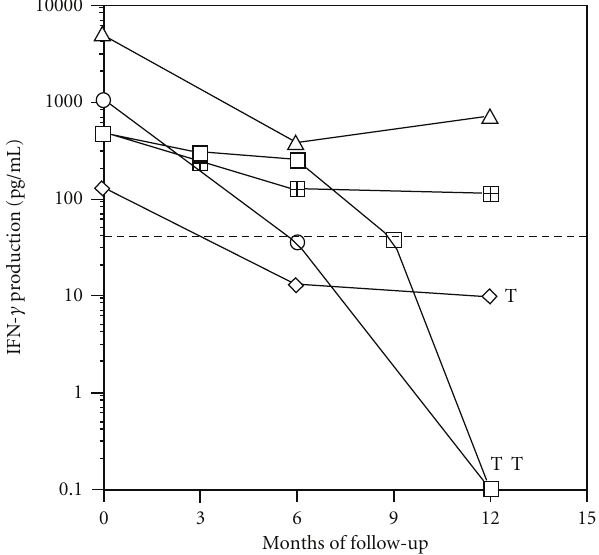
Figure 5: Evolution of Ag85-specific IFN- γ response in 5 HIV- positive latently infected subjects. Individual IFN- γ production (pg/mL) of PBMC in response to Ag85 from 5 tuberculin- positive/HIV-positive subjects at baseline t = 0 and 3, 6, 9, and 12 months later. T = diagnosis of active tuberculosis. Dashed line: mean of IFN- γ production minus 2SD in tuberculin negative/HIV positive